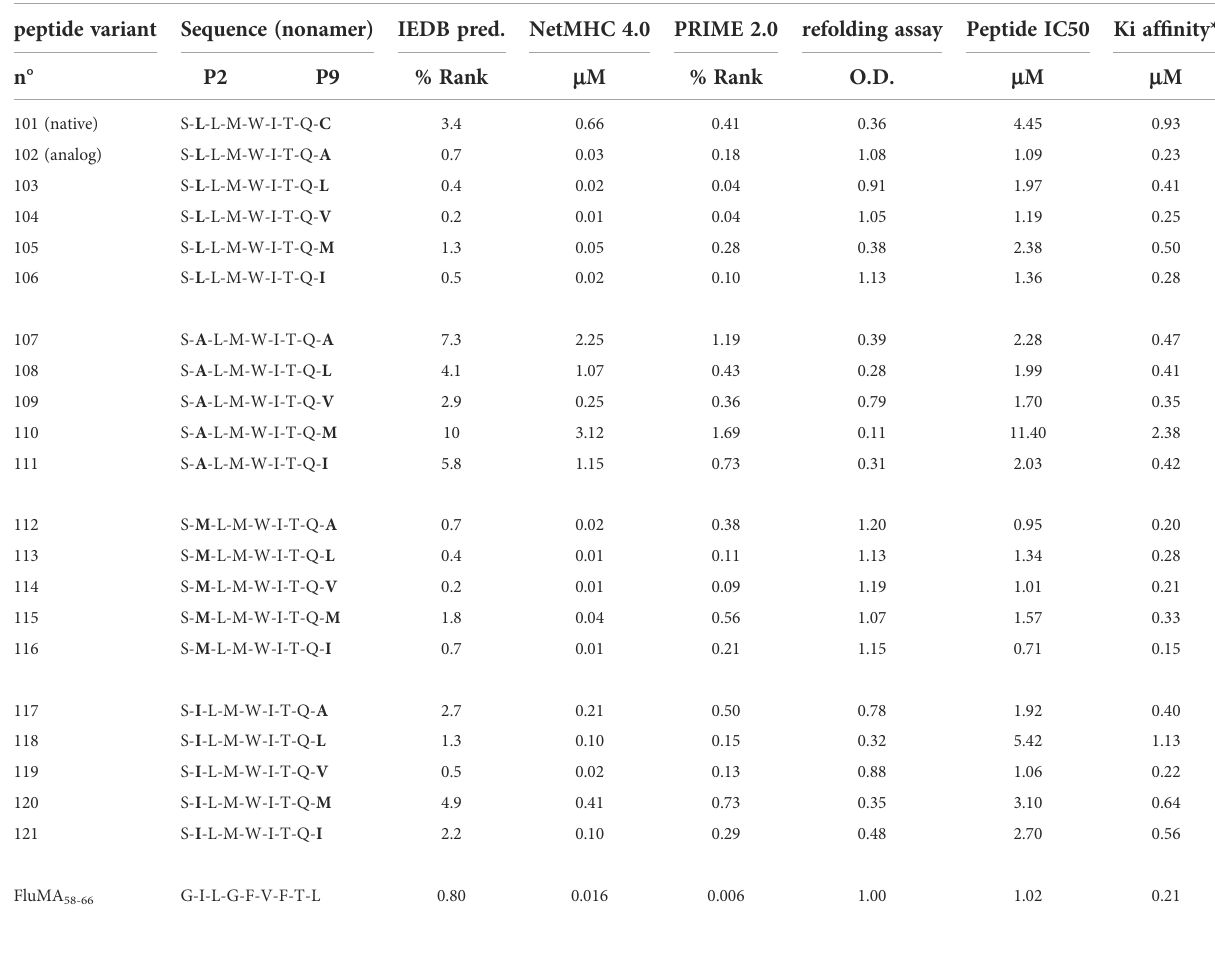
TABLE 2 Sequences, algorithm-based and biophysical values of HLA-A*0201-restricted NY-ESO-1 157-165 P2/P9 peptide variants and Flu Matrix 58- 66 control. NY – ESO-1